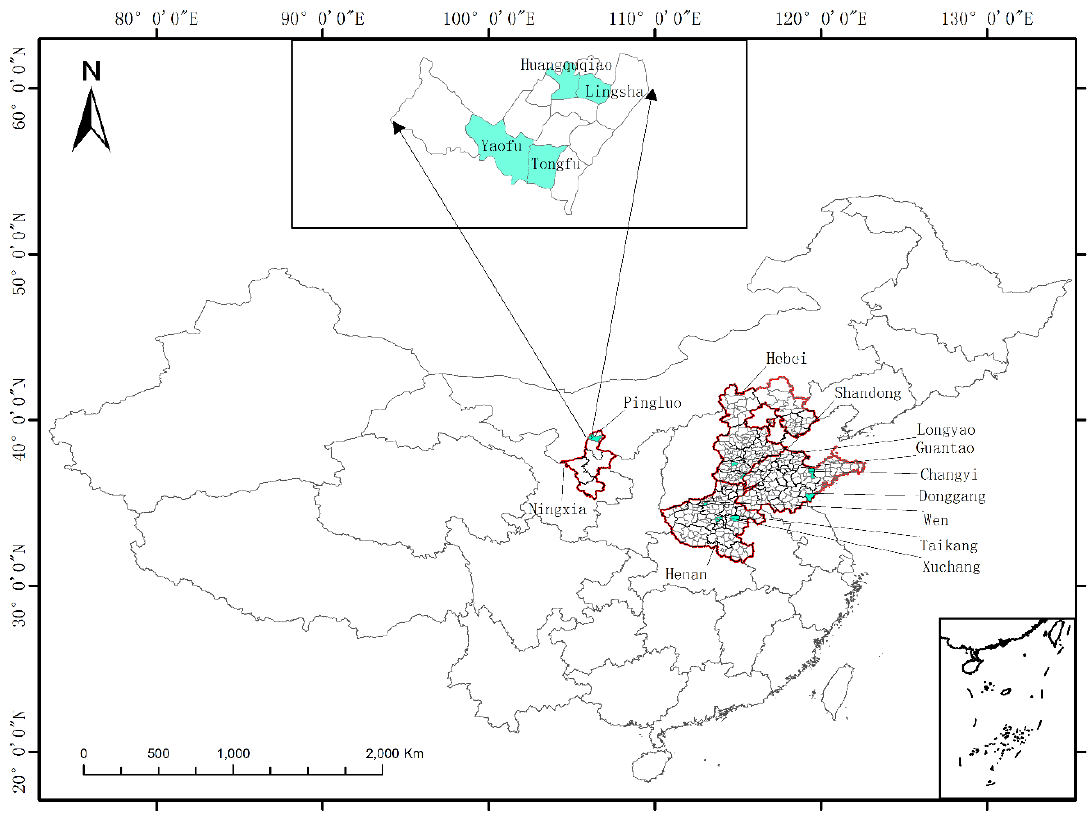
Figure 1. The distribution of survey areas. (Data source: http: // bzdt.ch.mnr.gov.cn / index.html. Map approval number is GS